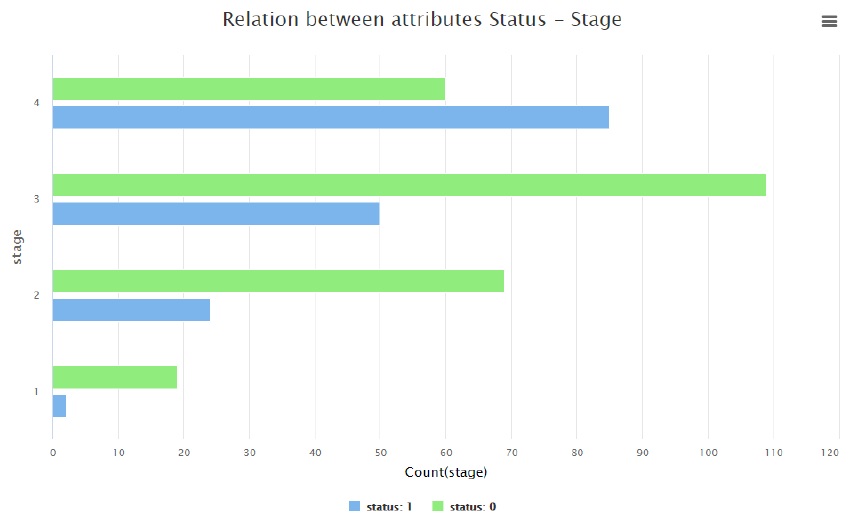
Figure 4. Association of the status attribute (label) and the stage attribute, where the alive patients are represented by the green bars and the deceased patients by the blue